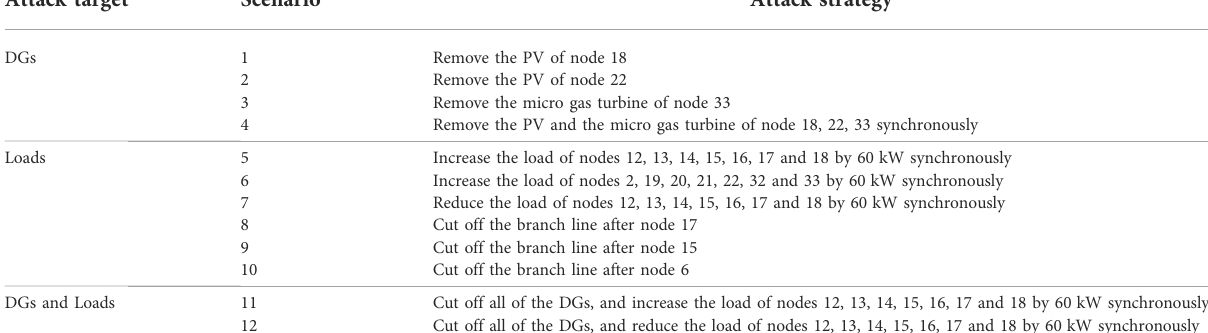
TABLE 2 Cyberattack scenarios.